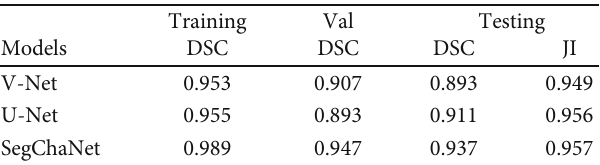
Figure 5: SegChaNet, U-Net, and V-Net model with and without Table 8: Evaluation of segmentation accuracy in DSC, JI for 3 models.